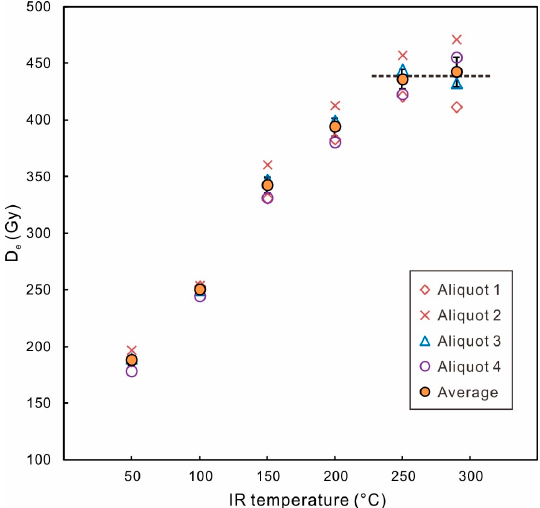
Figure 1. D e versus IR stimulation temperature in the MET-pIRIR protocol. The sample used is 14LC-11.0, from the top of the L2 layer (second loess layer, corresponding to Marine Isotope Stage 6) in the Luochuan section, Chinese Loess Plateau (Zhang et al. [72]). Four aliquots were measured. The error bar of the average is the standard error calculated from four aliquots.